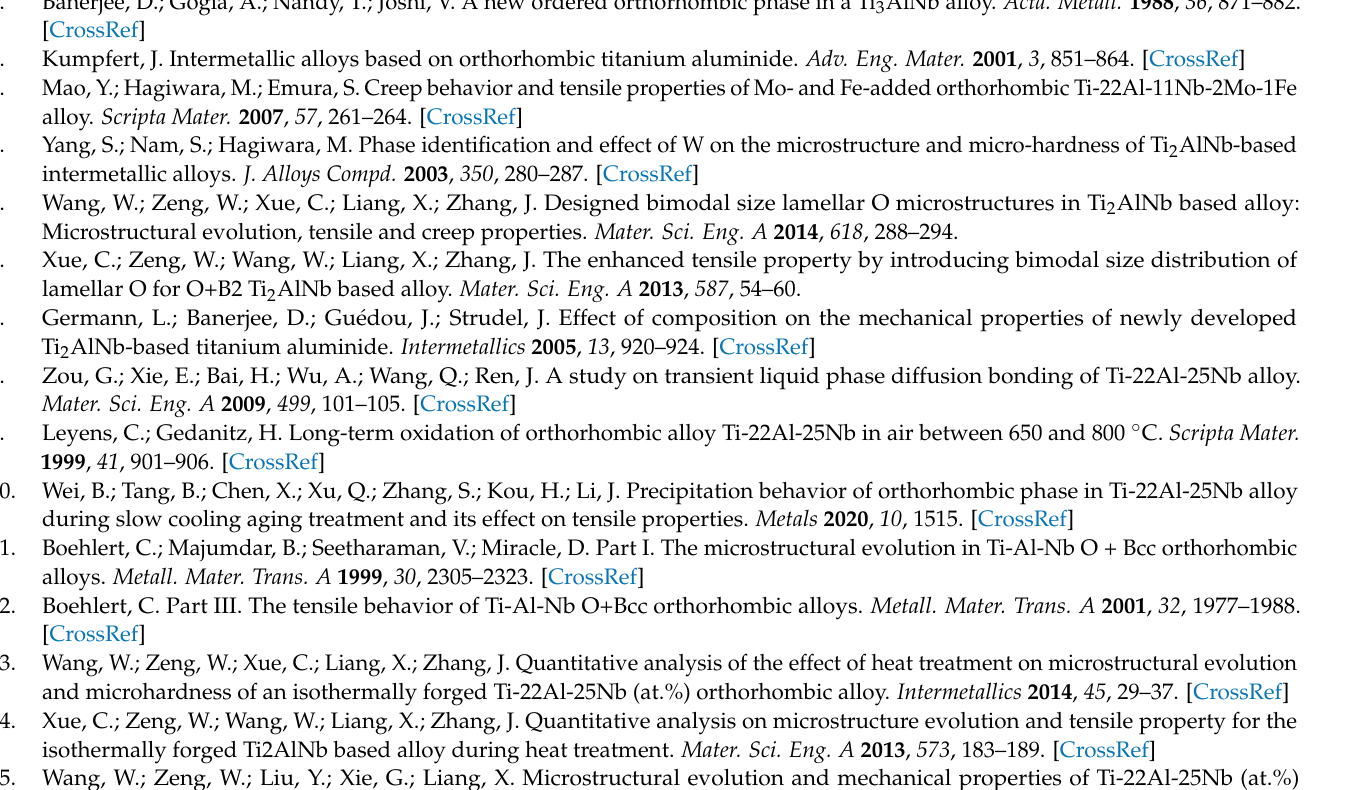
4. The microcracks nucleated at the α 2 /B2 phase boundaries or within the α 2 particles, and microcracks propagated along the α 2 /B2 phase boundaries or across the α 2 particles. The fracture surface shows the quasi-cleavage feature, which contains a large number of small and shallow dimples on planar